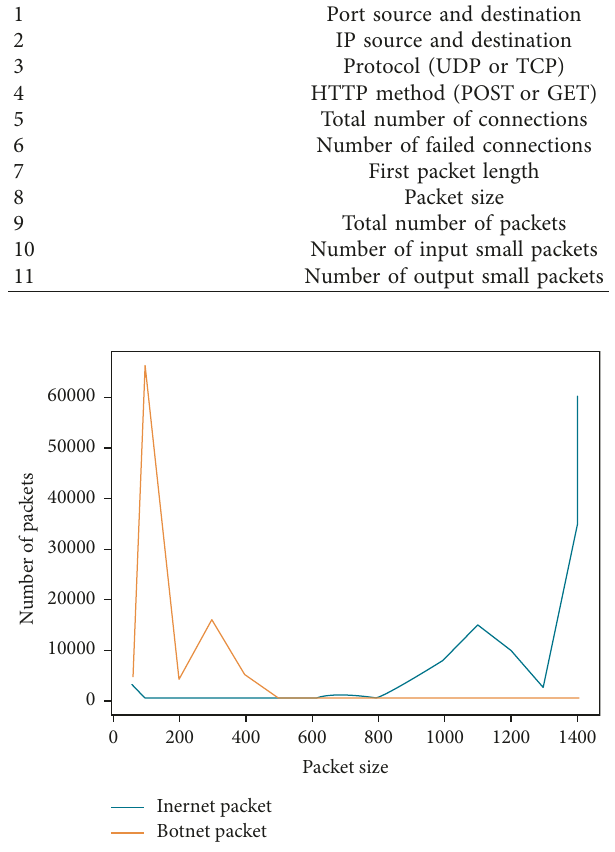
Figure 2: Packet distribution in general Internet.